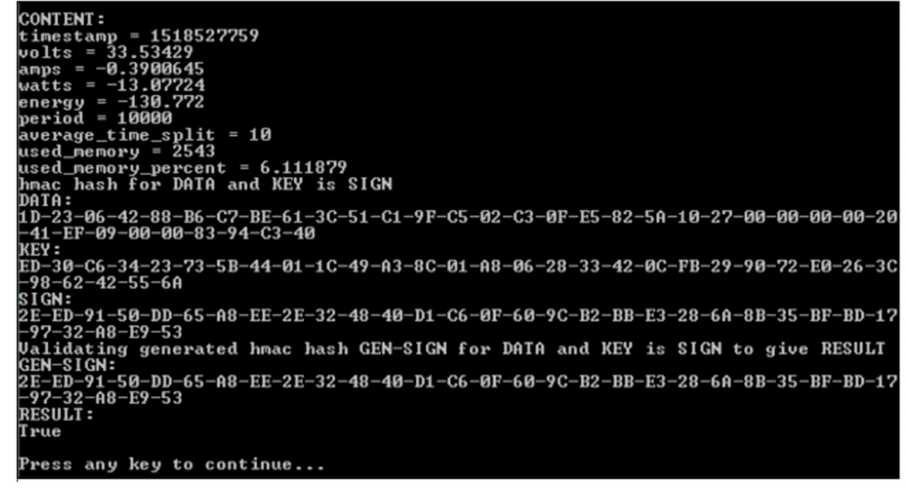
Figure 14. REGUS validating the human readable data is the same as the compressed data received from the solar